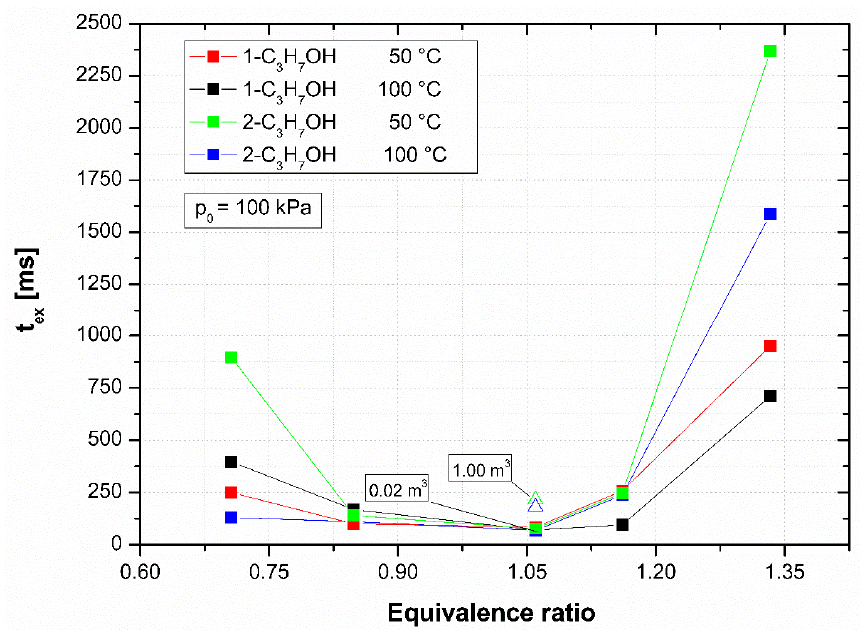
Figure 10. t ex versus Φ = 0.7–1.3 for propanol isomer–air mixtures at various initial temperatures and mixture compositions, p 0 = 100 kPa.